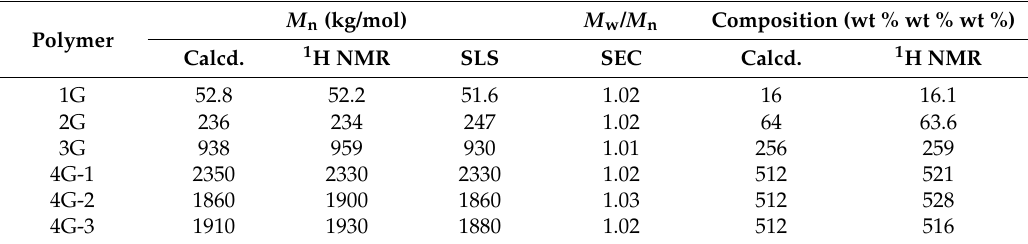
Table 5. Characterization results of highly dense DHB (PMMA)s (1G–4G).